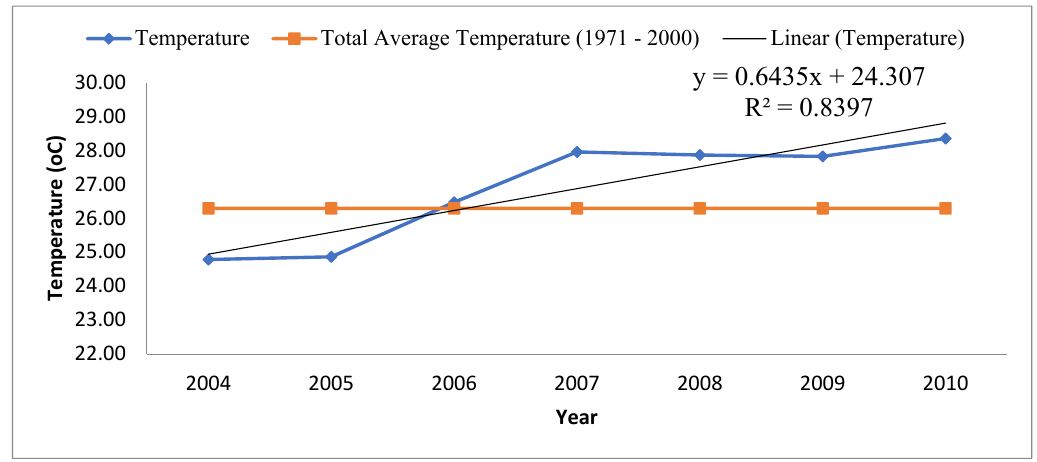
Figure 4. Total average annual temperature (°C) trend in the Ejura-Sekyedumase Municipality (2004–2010); NB: total average annual temperature (1971–2000) for the municipality is 26.3 °C.